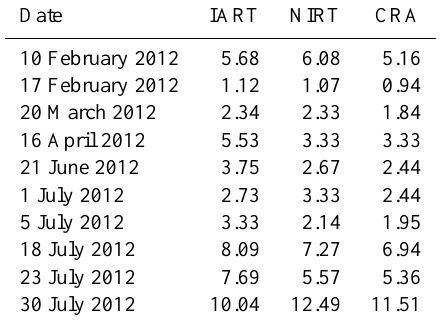
Table 4. Number of all and valid GPS rays and number of voxels that valid GPS rays passed through. No. of No. of No. of ray-passed Date all rays valid rays voxels